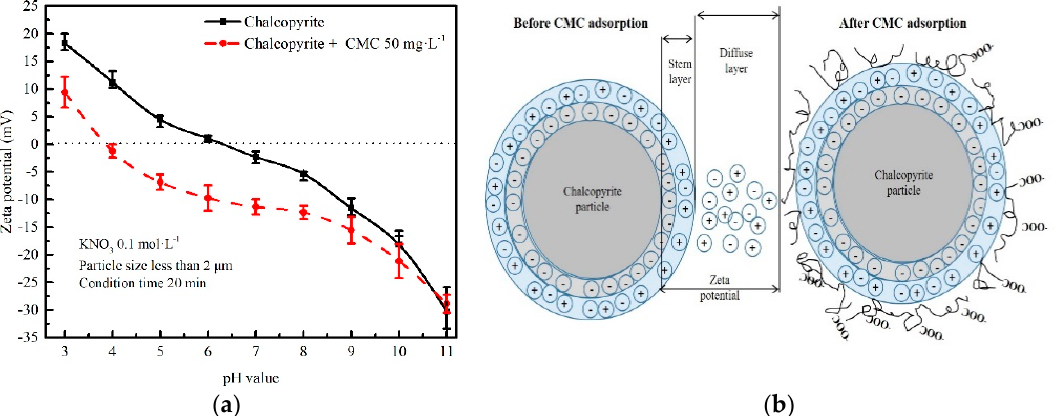
Figure 4. ( a ) pH dependence of the zeta potential of chalcopyrite in the absence and presence of CMC; ( b ) electrostatic adsorption mechanism of CMC on chalcopyrite.